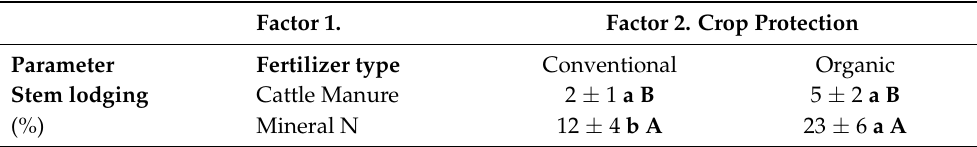
Means are labelled with the same capital letter within each column and lower-case letter within each row and are not significantly different according to Tukey’s honest significant difference test (THSD) test ( p < 0.05). Azita and Solstice produced the same grain yield with cattle manure as the fertilizer, while Solstice produced significantly higher grain yields than Aszita with mineral N fertilizer (Table